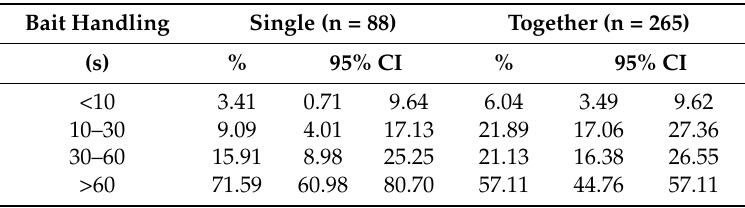
Table 8. The percentage of the different bait handling time periods (seconds) of dogs offered bait when they were alone (single) or together with other